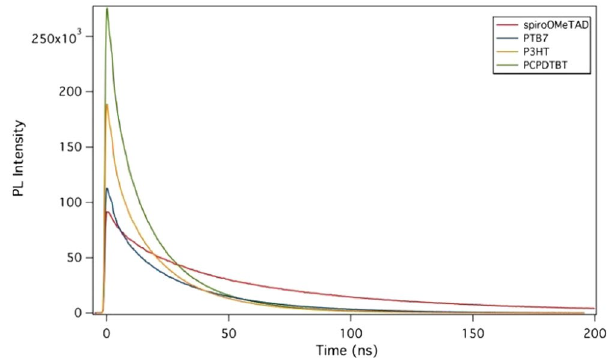
Figure 5. PL decays of the perovskite\HTM films on glass substrate.